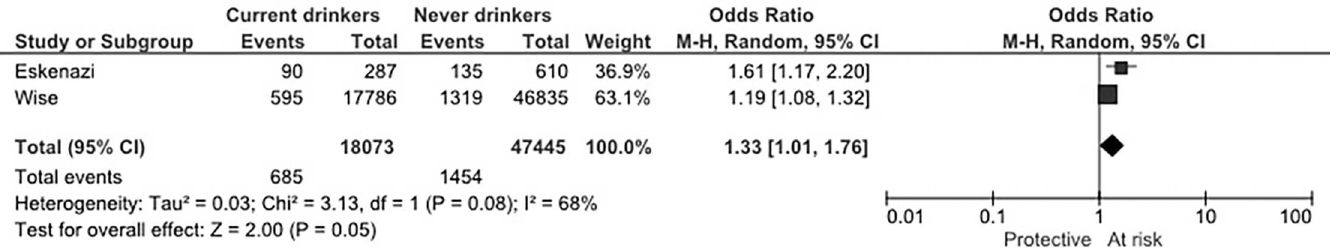
Fig 3. Study specific and summaryodds ratio (OR) of uterine myoma for current versus no alcohol intake. CI: confidenceinterval.